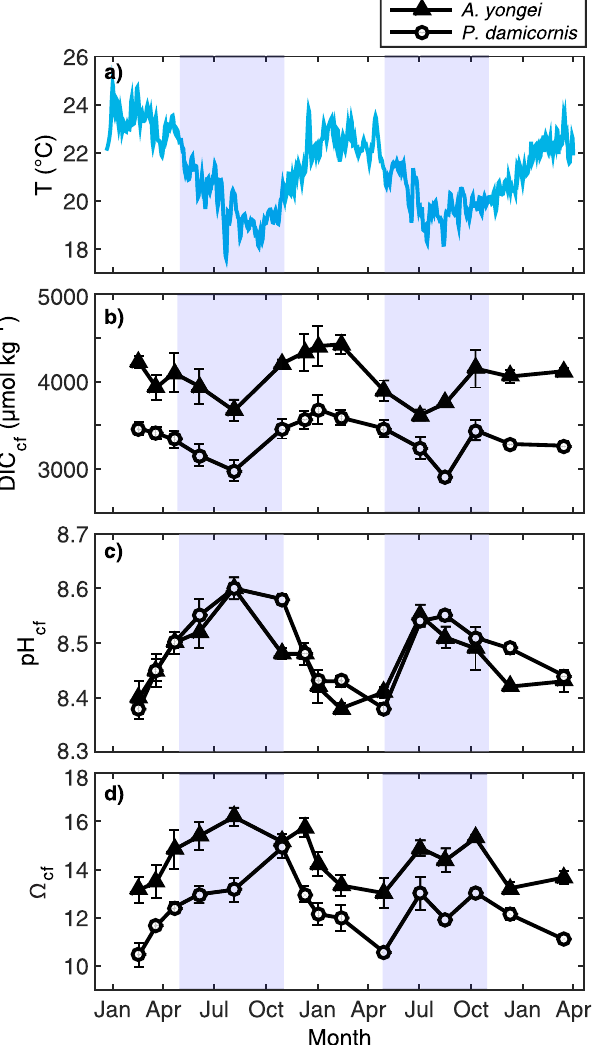
Figure 3. Time-series of seasonal changes in seawater temperature and calcifying fluid parameters (DIC cf , pH cf , Ω cf ). ( a ) Seawater temperature ( b ) pH cf , ( c ) predicted dissolved inorganic carbon (DIC cf ), and ( d ) Ω cf for coral the species Acropora yongei and Pocillopora damicornis averaged ( ± 1 SE) over each growth period. Light blue shading denotes winter and unshaded areas denote summer, defined based on seasonal changes in temperature and